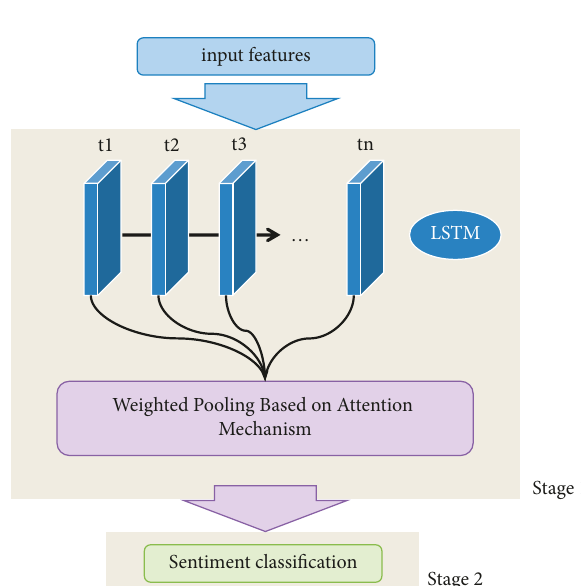
Figure 2: LSTM network structure based on attention